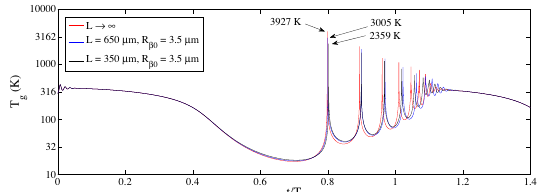
Figure 8. Temporal evolution of T g at different distances between bubble centers ( L ) ( T = 50 l s, R a 0 = 4.5 l m, T 0 = 298.15